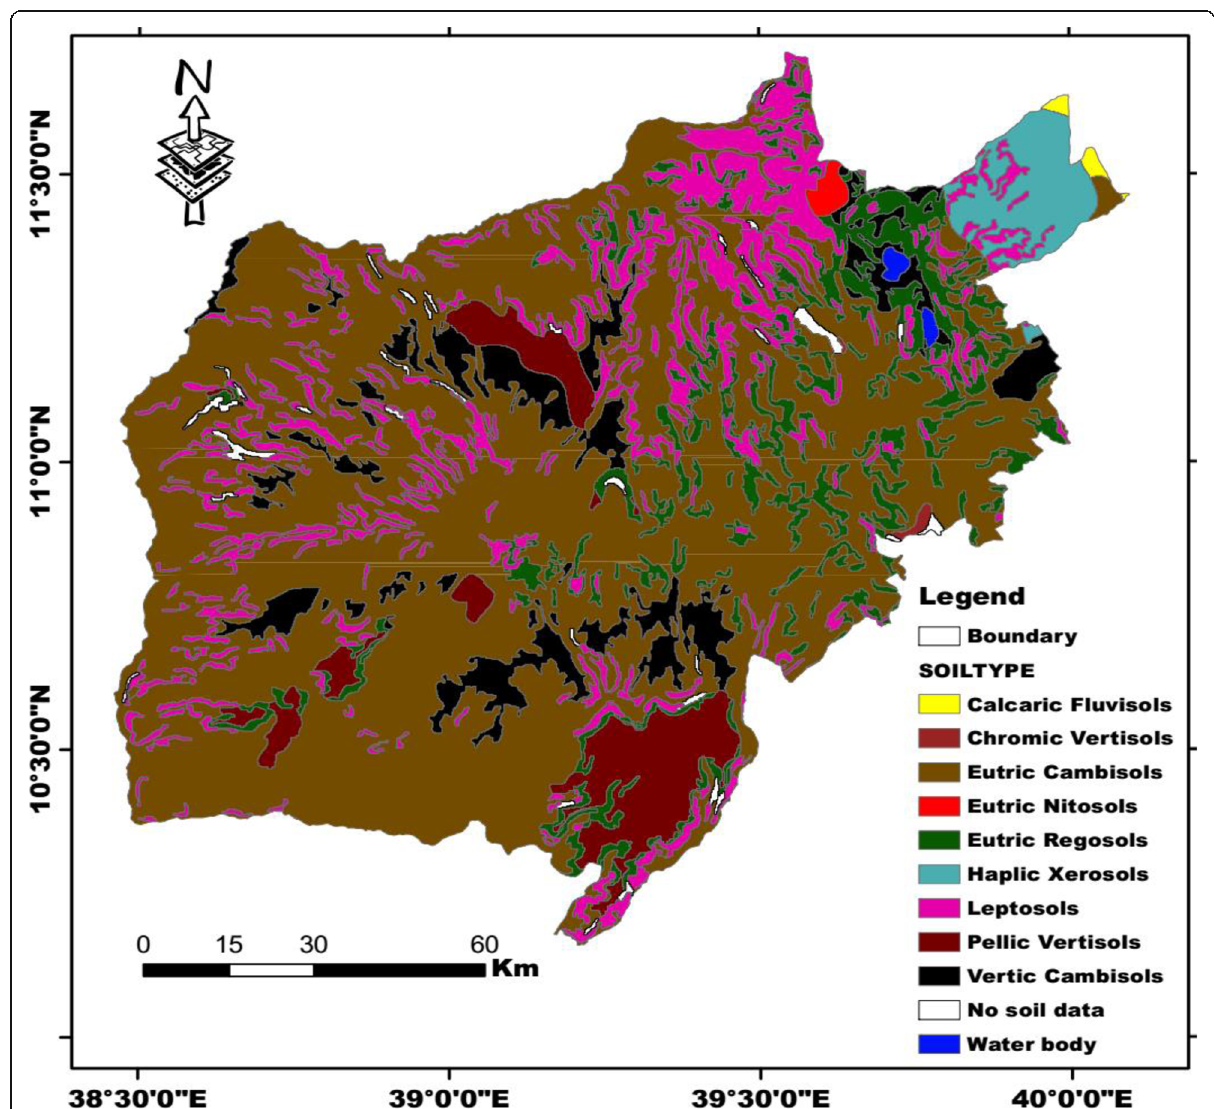
Fig. 7 The spatial distribution of soil type associations found in South Wollo administrative zone